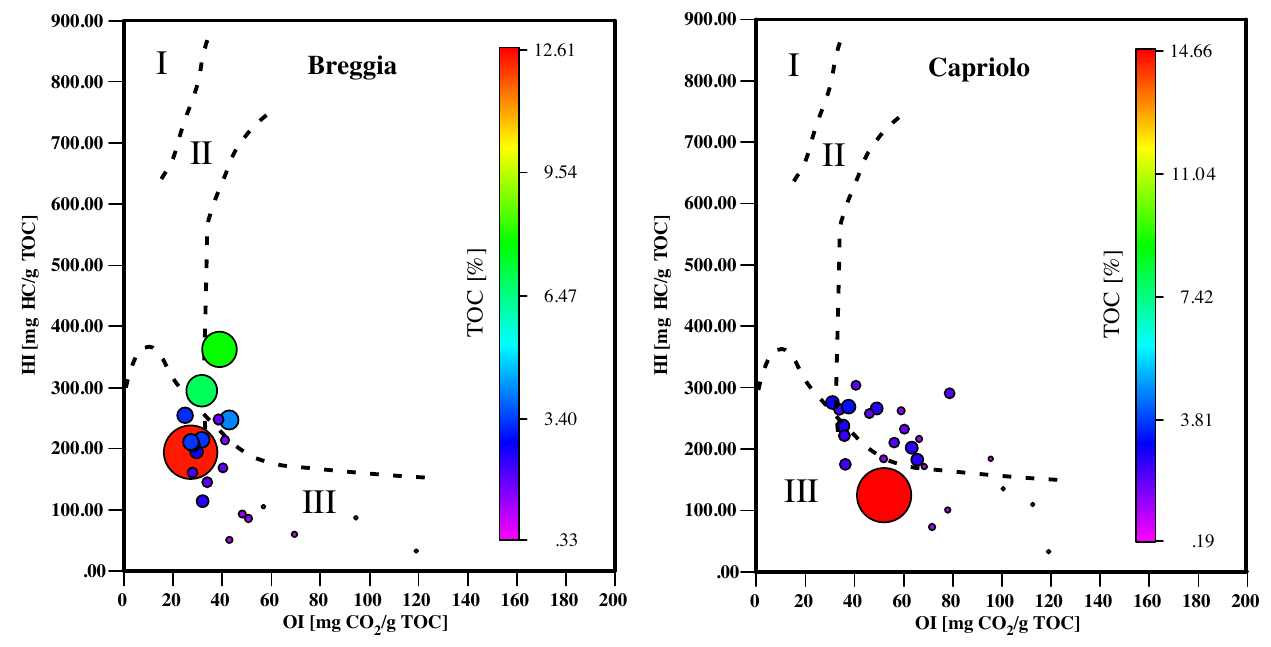
Fig. 4. Hydrogen index (HI) values versus oxygen index (OI) values in a Van Krevelen-type diagram for mudstone samples from the Breggia Föllmi et al., Fig. 4 and Capriolo